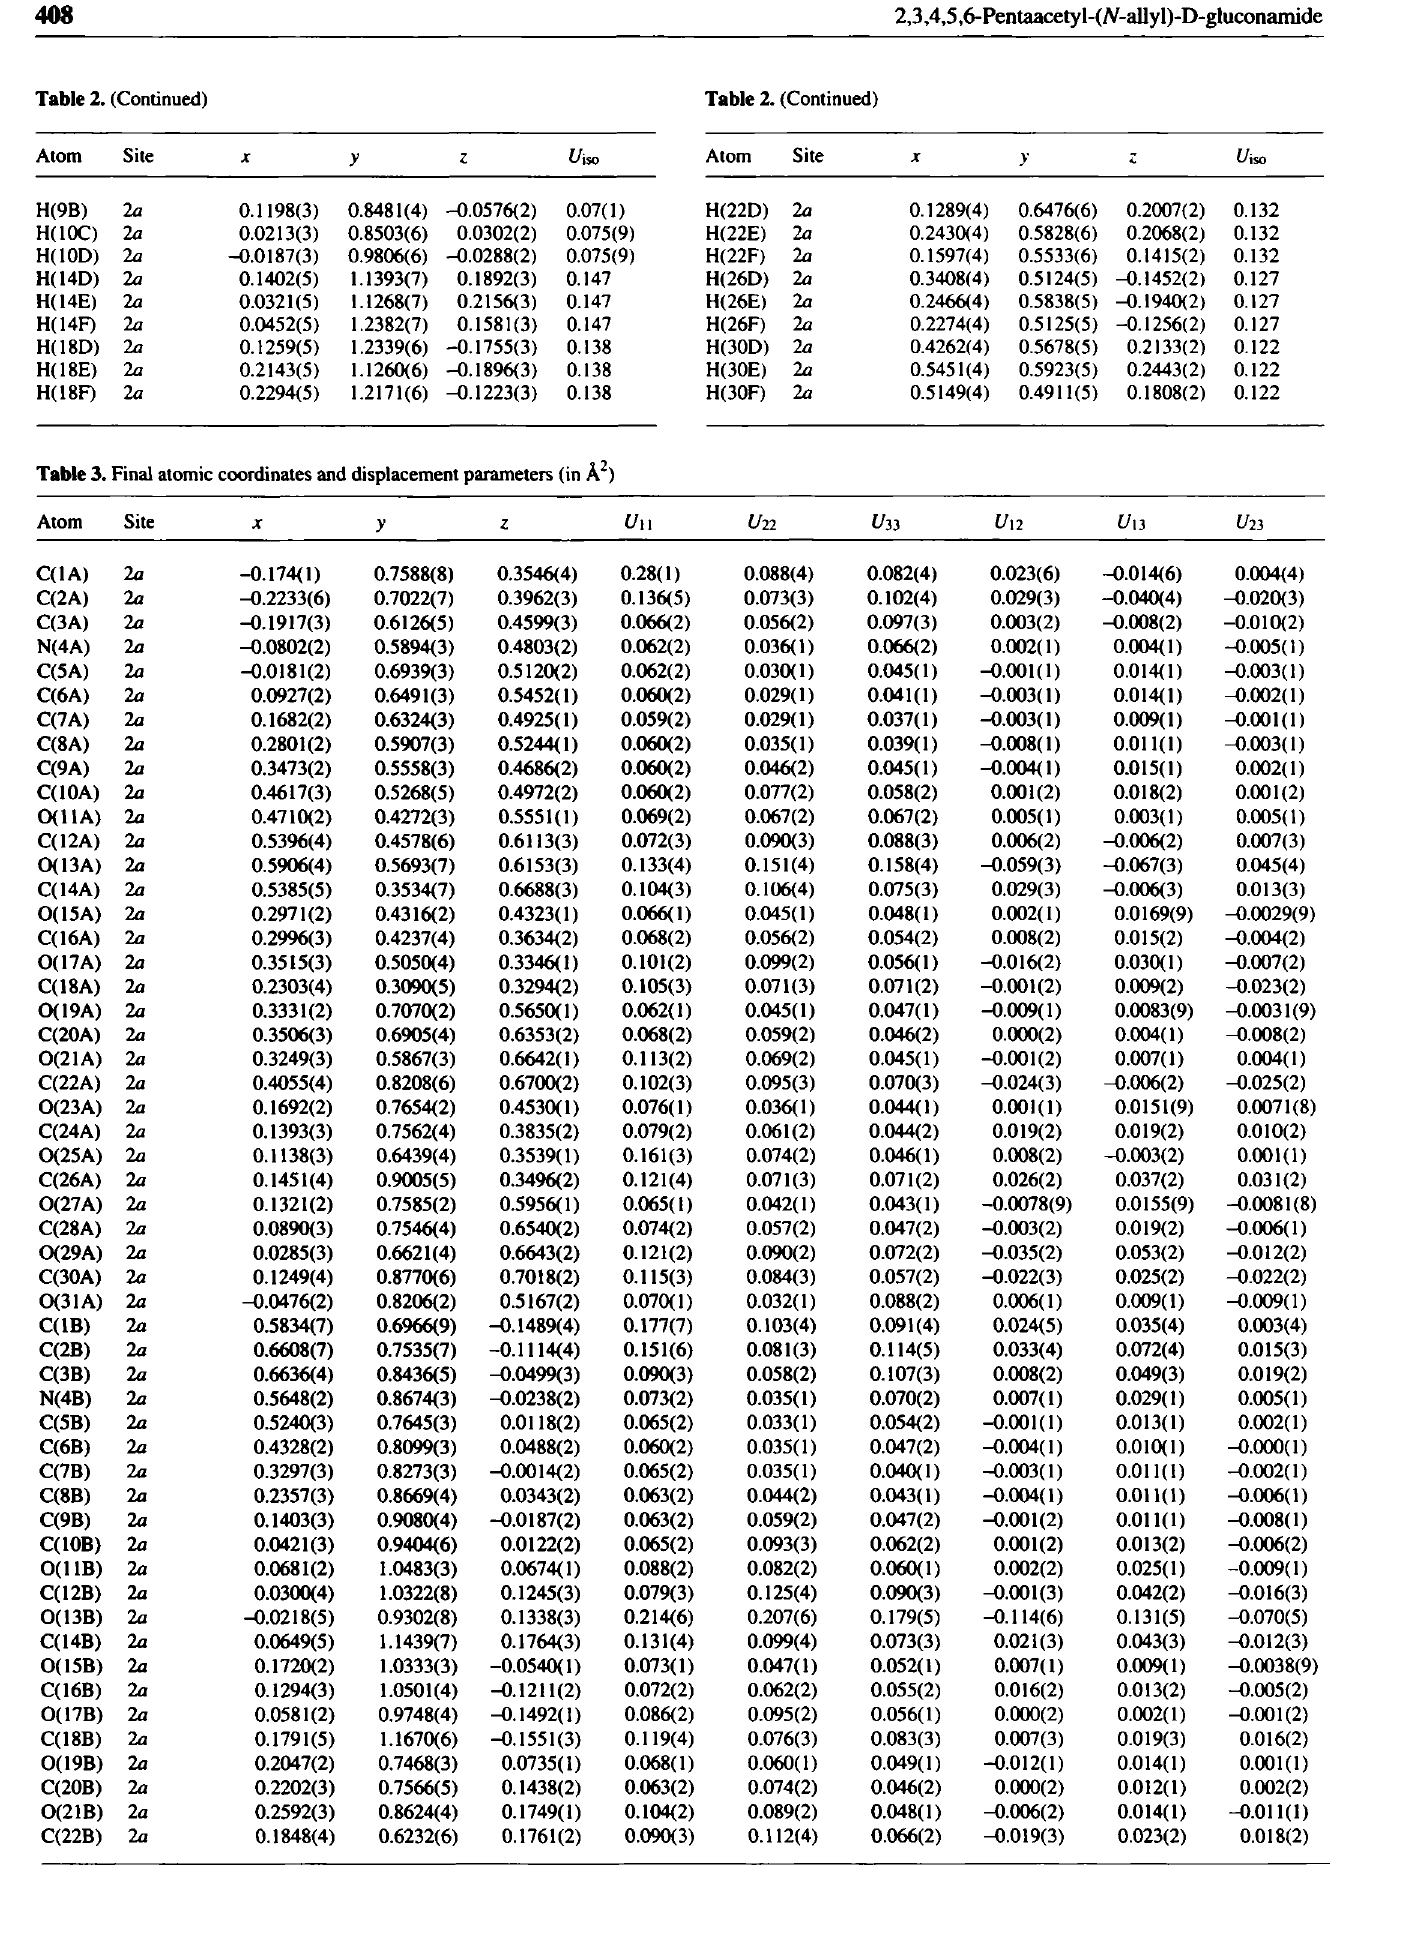
Table 3. Final atomic coordinates and displacement parameters (in